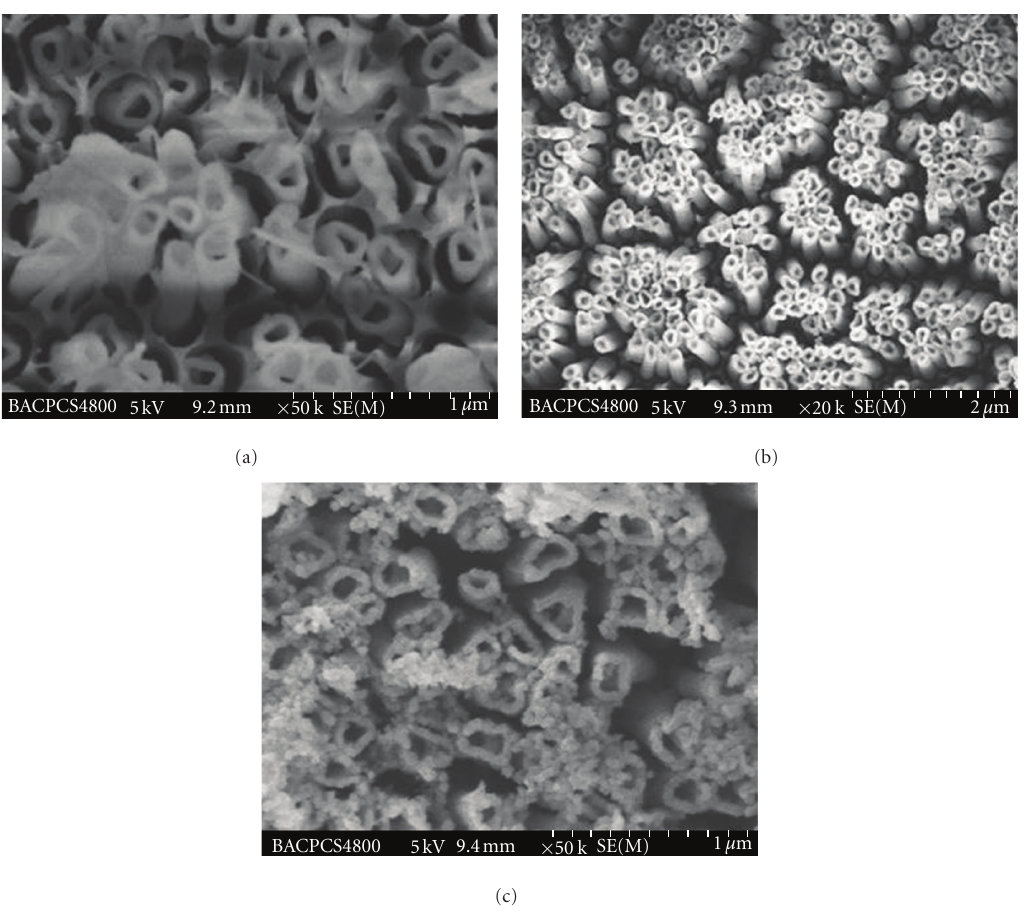
Figure 4: SEM micrographs of TiO 2 nano tubes prepared with di ff erent concentration of deposition solution ((NH 4 ) 2 TiF 6 ): (a) 0.05 mol/L, (b) 0.1 mol/L, (c) 0.3mol/L.